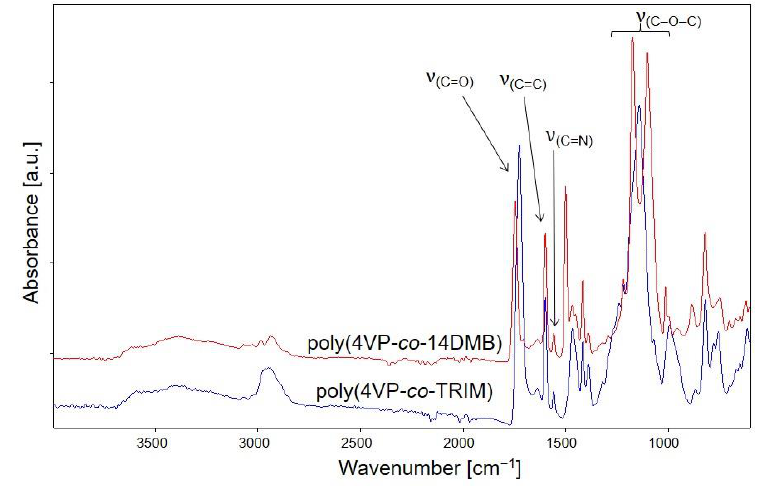
Figure 2. ATR-FTIR spectra of obtained 4VP copolymers.